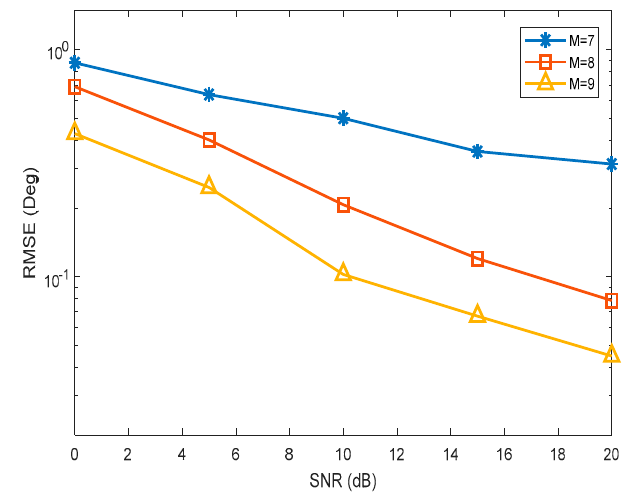
Figure 3. The RMSE versus snapshots for different methods ( 8 M = and SNR B10d = ).